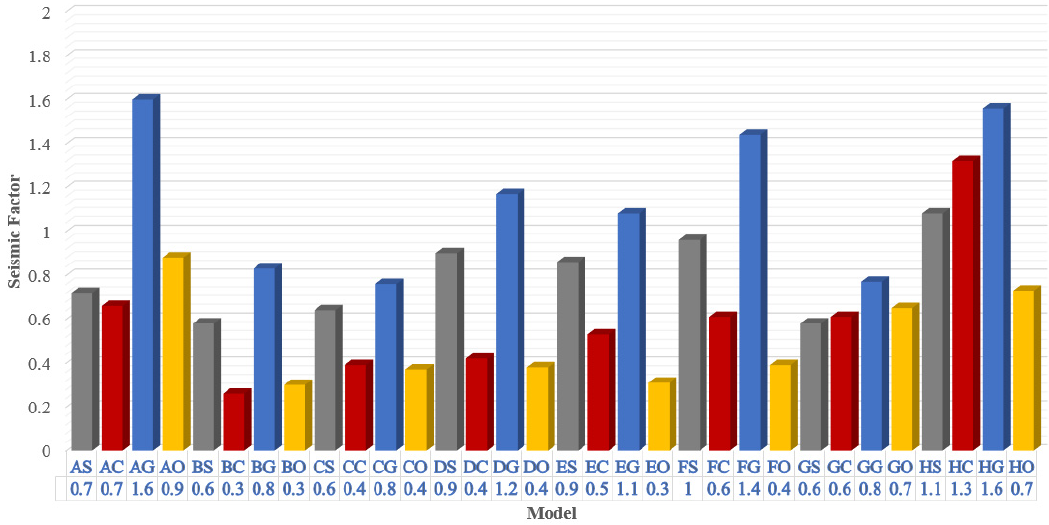
Figure 16. Seismic factor of the models